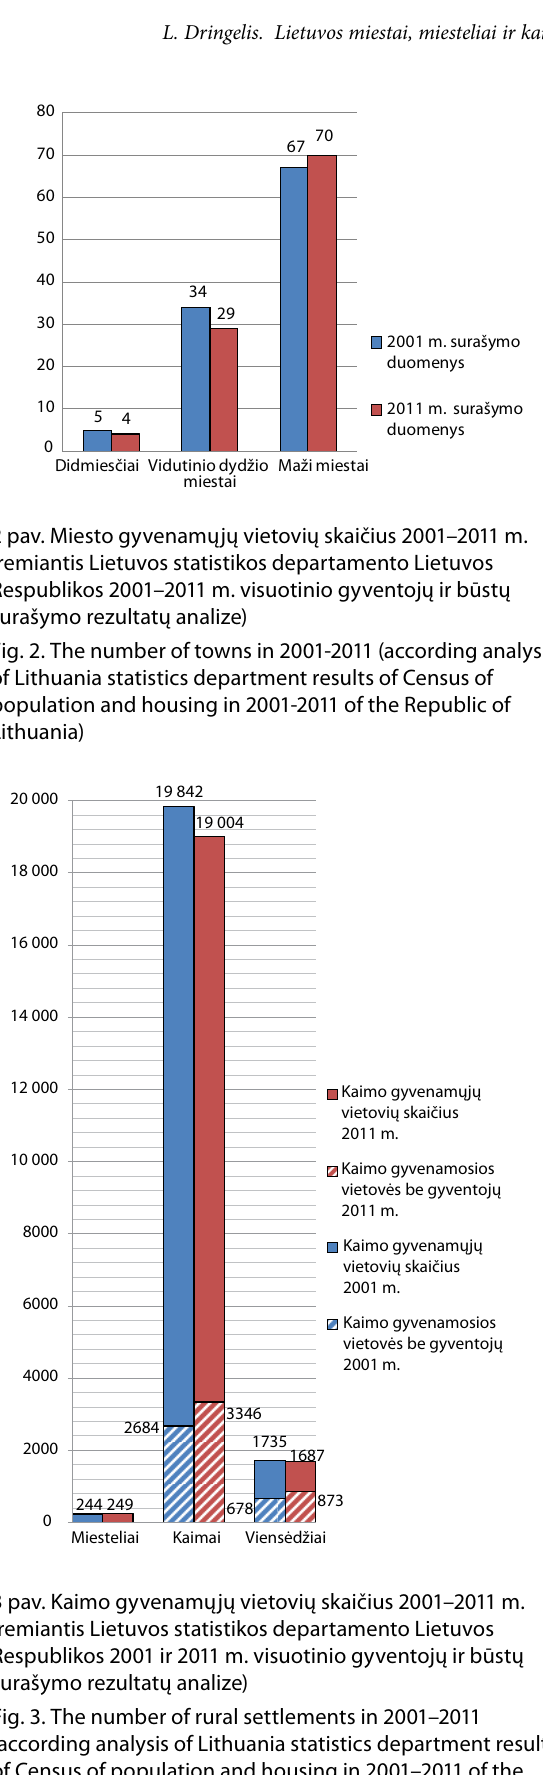
fig. 3. The number of rural settlements in 2001–2011